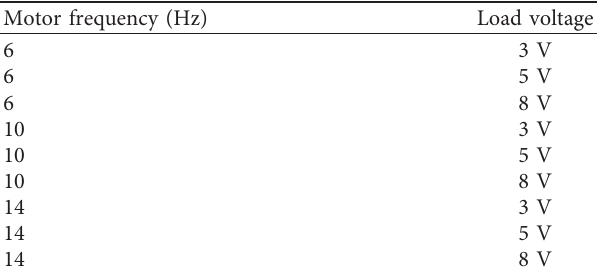
Table 3: 9 Working